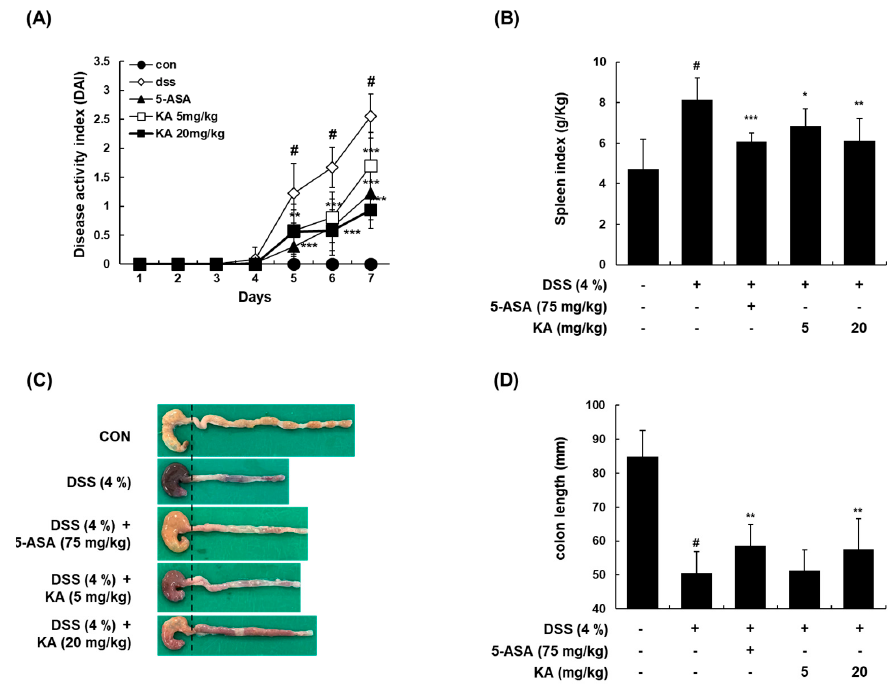
Figure 6. Ameliorative effects of KA on dextran sulfate sodium (DSS)-induced colitis in mice. ( A ) Mice were administered with 4% DSS in drinking water for 7 days with KA (5 or 20 mg/kg/day, i.p.). 5-ASA (75 mg/kg/day, p.o.) was used a positive control. DAI were evaluated daily. ( B – D ) On day 7, the mice were sacrificed, and their colon and spleen were obtained. The colon length and spleen weight of each mouse were evaluated. Values are the mean ± SD ( n = 12); # P < 0.05 vs. the vehicle-treated control group; * P < 0.05, ** P < 0.01, *** P < 0.001 vs. the DSS-treated